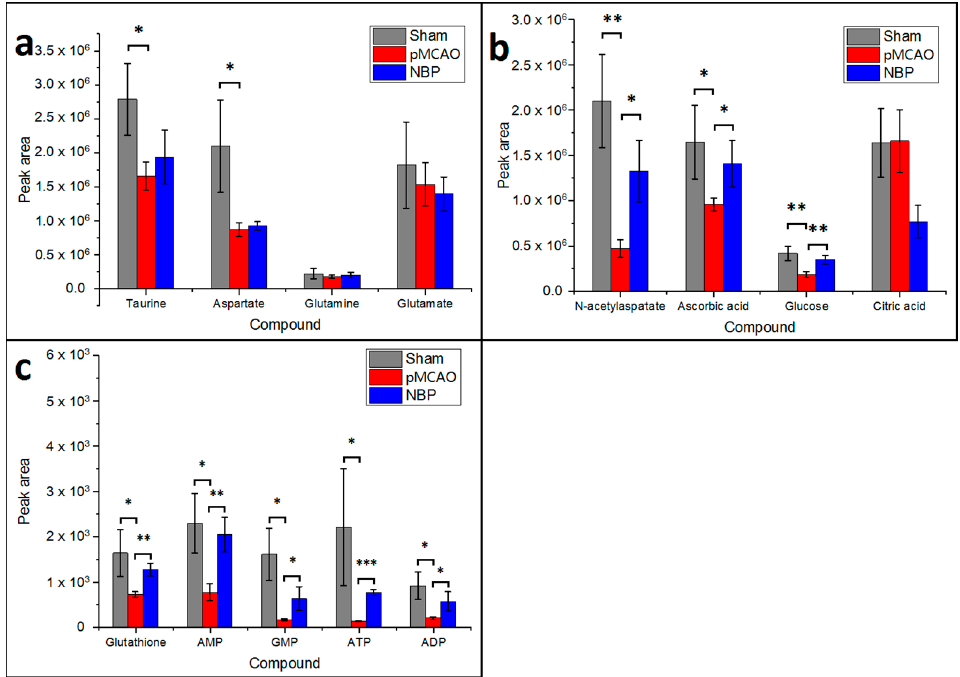
Figure 4. MRM MS signals of metabolites extracted from the ischaemic hemisphere of the rat brain. Data are shown as the mean ± SD ( n = 3). The asterisks indicate significant differences (*** p < 0.001, ** p < 0.01, and * p < 0.05). Sham: sham surgery group; pMCAO: pMCAO group; NBP: dl-3-n-butylphthalide-treated group.